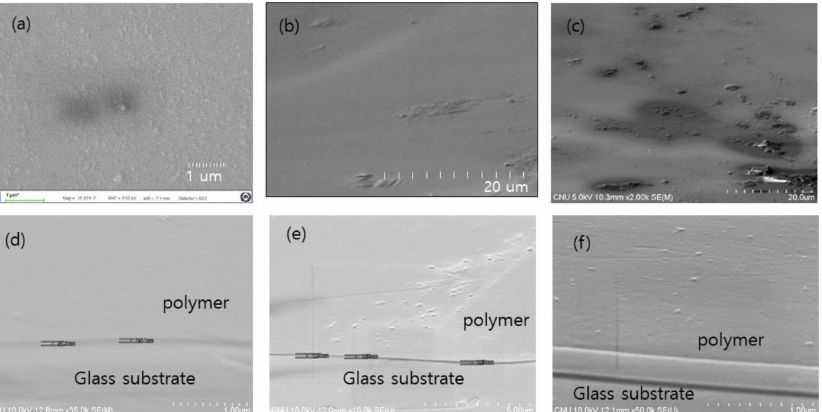
Figure 8. SEM images of polymer films. ( a ) Fresh PEE film morphology deposited with 10 g/L concentration. ( b ) Fresh film with 0.1 g/L concentration. ( c ) Film with 0.1 g/L concentration. ( d – f ) SEM images of the used polymer films obtained from PNL global company. In order to observe the morphologies more clearly, the samples were slightly tilted for SEM